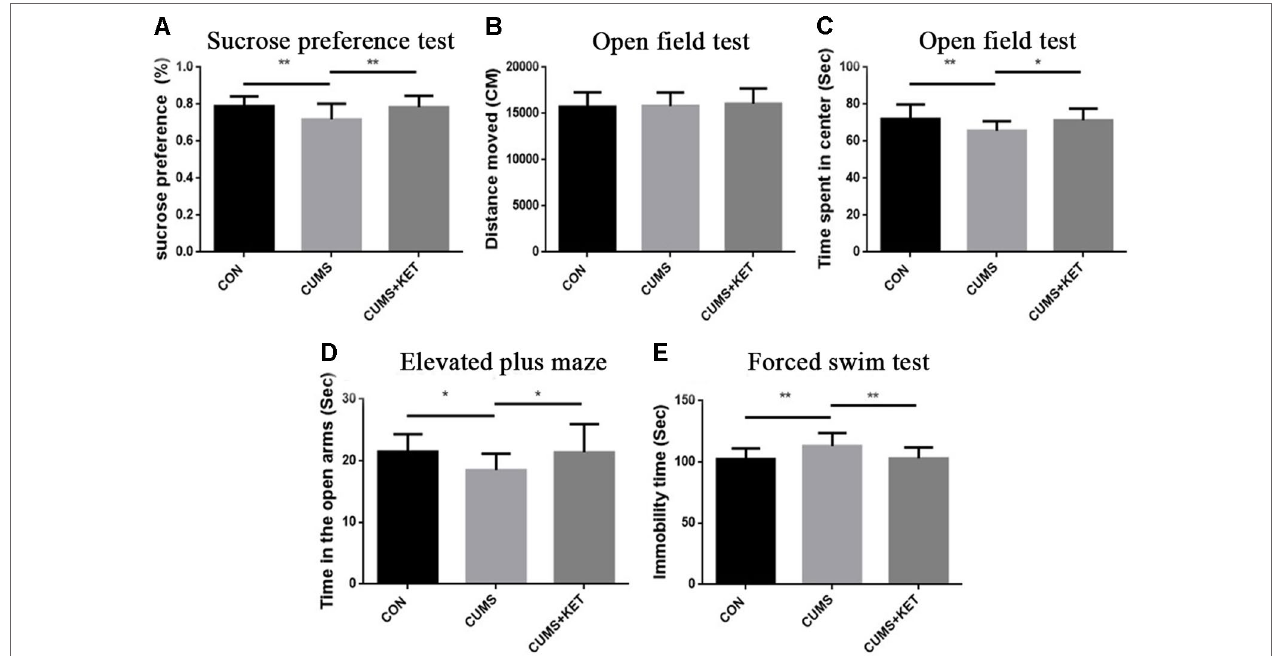
FIGURE 2 | Effects of chronic unpredictable mild stress (CUMS) on the anhedonia, anxiety, and depression-like behaviors of C57BL/6 mice, and ketamine reversal of these behaviors. (A) Preference for the sucrose solution on the sucrose-preference test. (B) Total distance traversed in the open-field test. (C) Time spent in the center area of the open-field test. (D) Time in the open arms of the elevated plus-maze. (E) Duration of immobility in the forced-swim test. Data are expressed as mean ± SD; n = 21 per group. One-way ANOVA was used to compare differences among the CON, CUMS, and CUMS+KET groups (* p < 0.05, ** p <